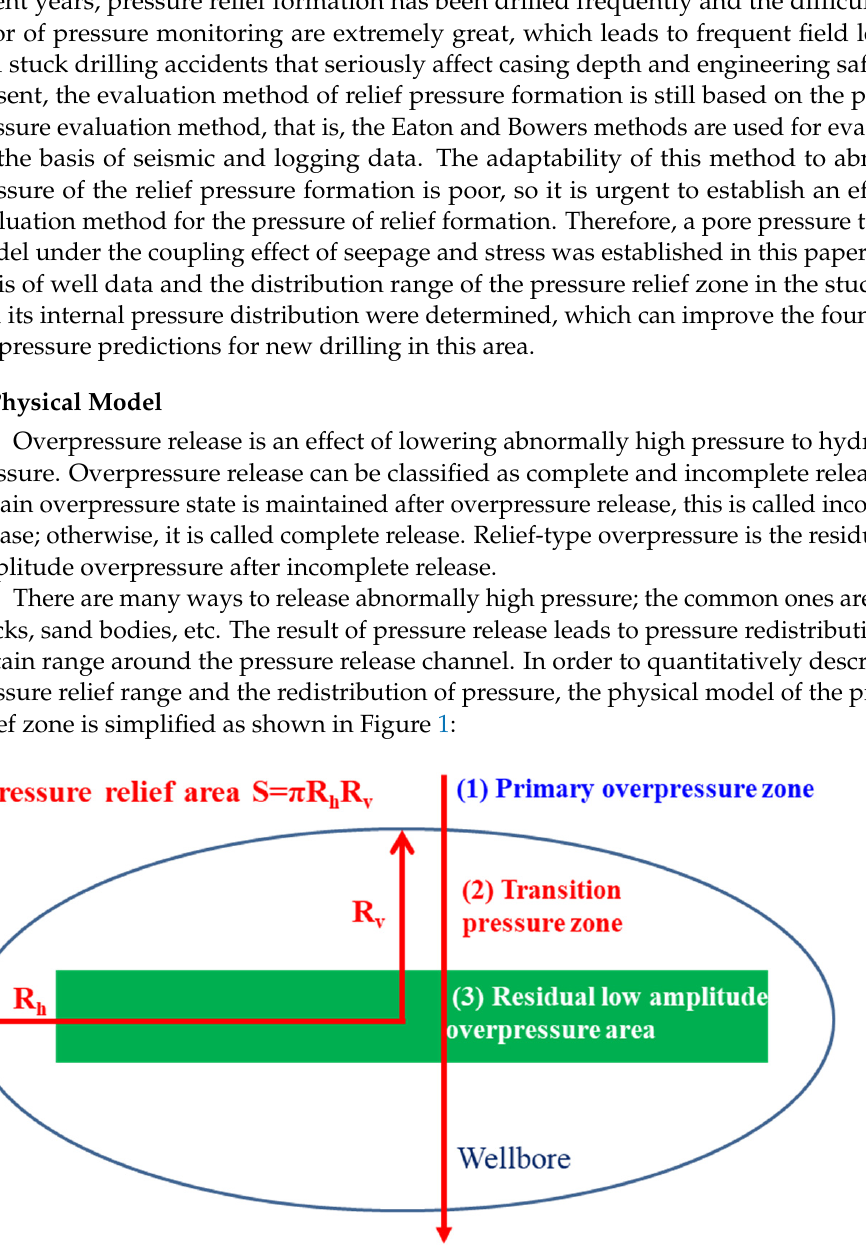
Figure 1. The physical model of the pressure relief zone. The pressure zone after pressure relief can be divided into three parts: (1) primary overpressure zone; (2) transition pressure zone; and (3) residual low amplitude overpres- sure area. The range of pressure relief can be quantitatively characterized by the following parameters: (1) lateral pressure relief radius R h : the horizontal distance from the center point of the low amplitude overpressure layer to the boundary of the pressure relief